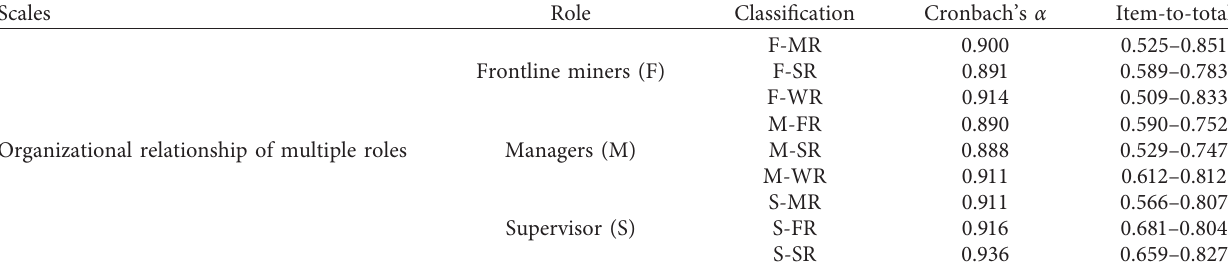
Table 3: Reliability and validity analysis results of organizational relationship